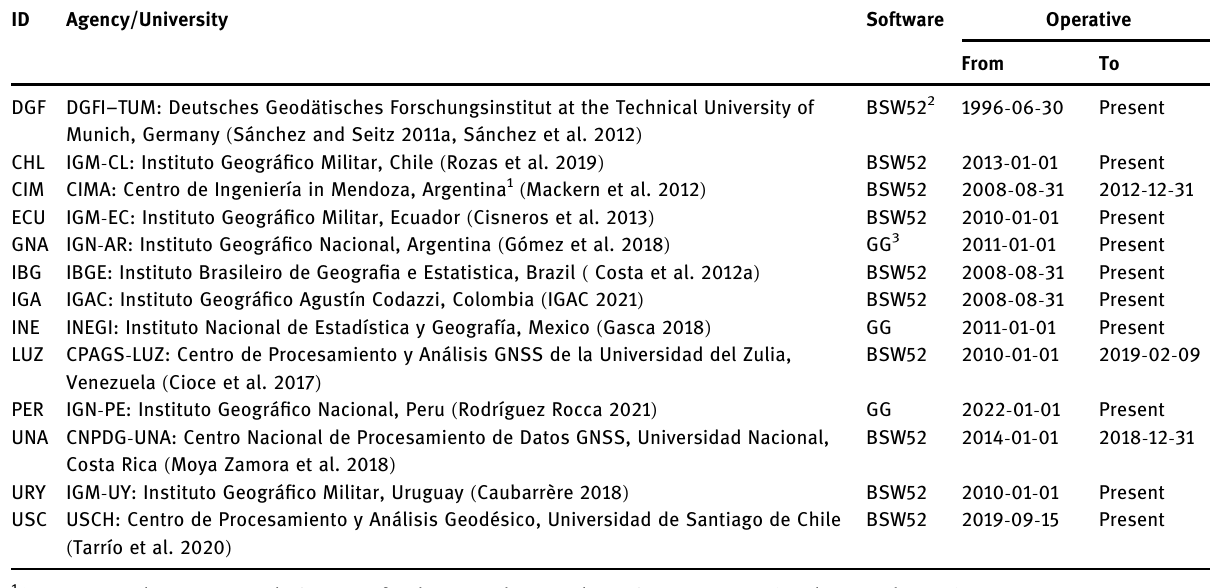
Table 1: SIRGAS analysis centres